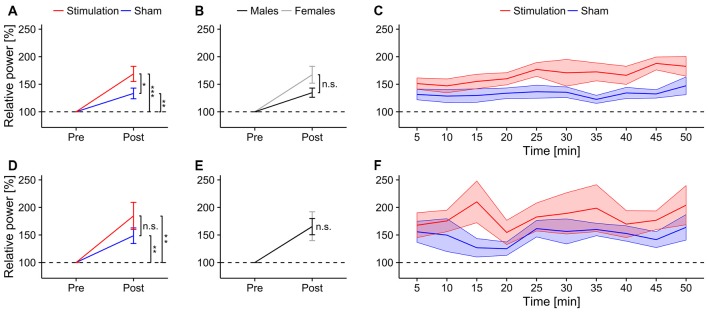
Ongoing alpha power. Top row: ongoing alpha power during mental rotation. Error bars and shaded areas depict SEM; asterisks code for significant differences (*<0.05, **<0.01, ***< 0.001). (A) Averaged relative alpha power after stimulation for stimulation and sham. (B) Averaged relative alpha power after stimulation for females and males. (C) Time-course of ongoing alpha power after stimulation for stimulation and sham group. Bottom row: ongoing alpha power during rest. (D) Averaged relative alpha power after stimulation for stimulation and sham. (E) Averaged relative alpha power after stimulation for females and males. (F) Time-course of ongoing alpha power after stimulation for stimulation and sham group.